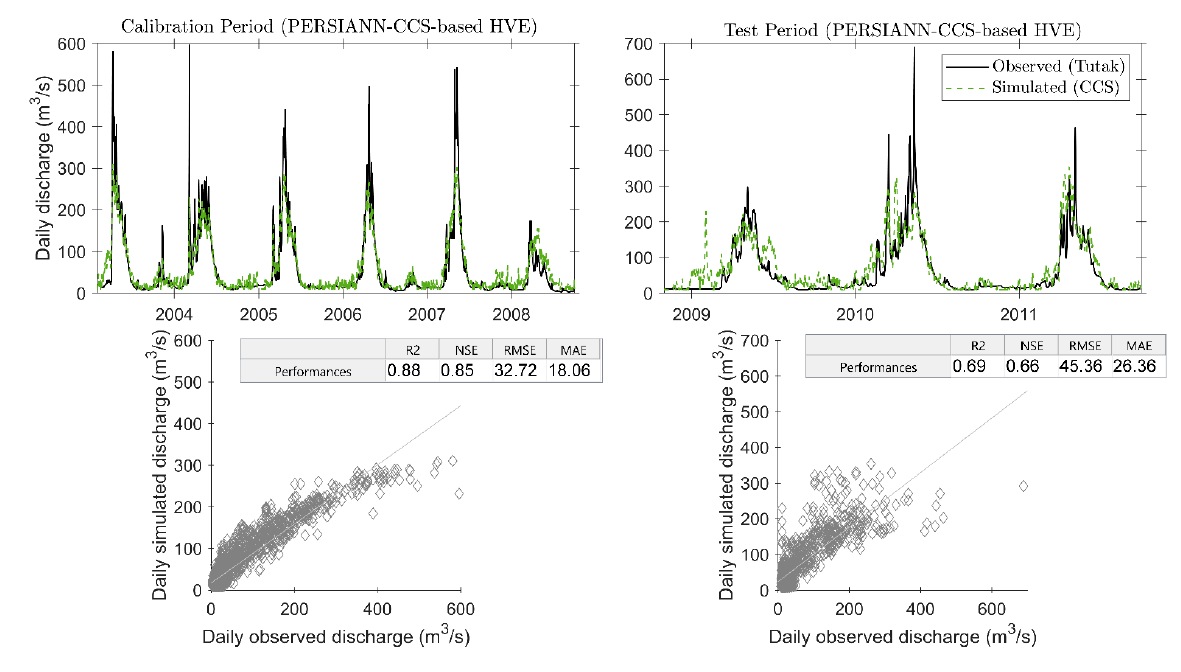
Figure 12. HVE results using PERSIANN-CCS SBP data.